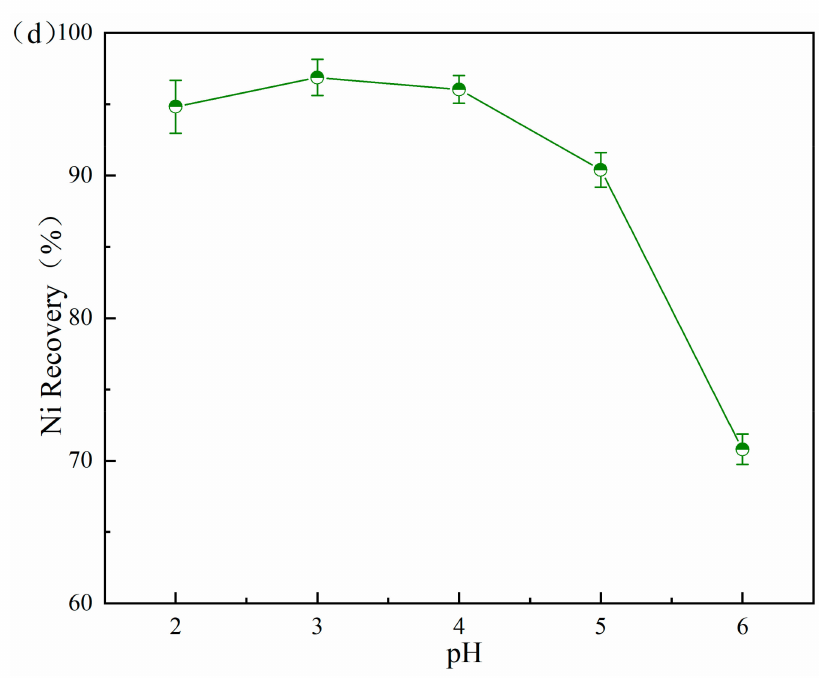
Figure 2. Evolution of COD Cr ( a ), TOC ( b ), and Ni 2+ ( c ) as a function of time at different initial pH. ( d ) The relationship between the Ni 2+ recovery rate and pH. Electrolysis conditions: electroplating sludge leaching solution (180 mL), temperature 25 ◦ C, and current density 50 A/m 2